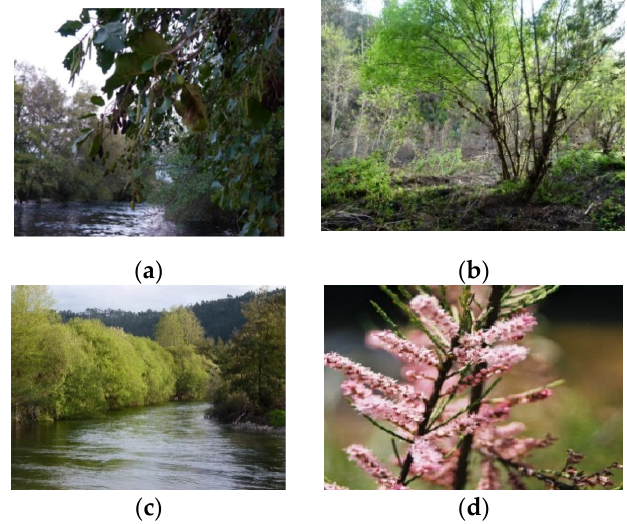
Figure 3. Alders ( a ), ash ( b ), willows ( c ) and Tamarix ( d ) (retrieved from [34]).